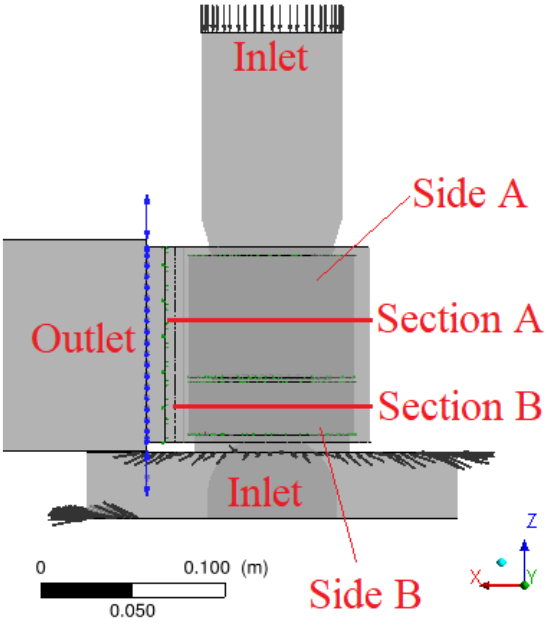
Figure 6. Schematic diagram of fan flow